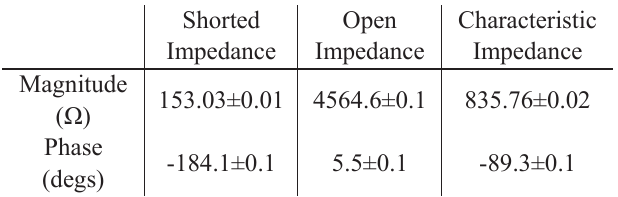
Table 1: Values from characteristic impedance measurement. Errors to one standard deviation.